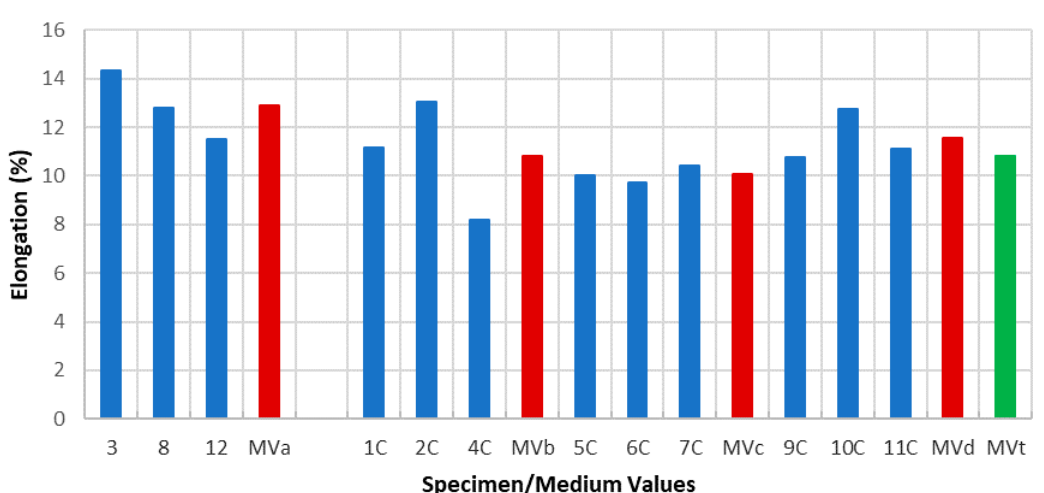
Figure 8. Elongation vs. specimen and medium values.